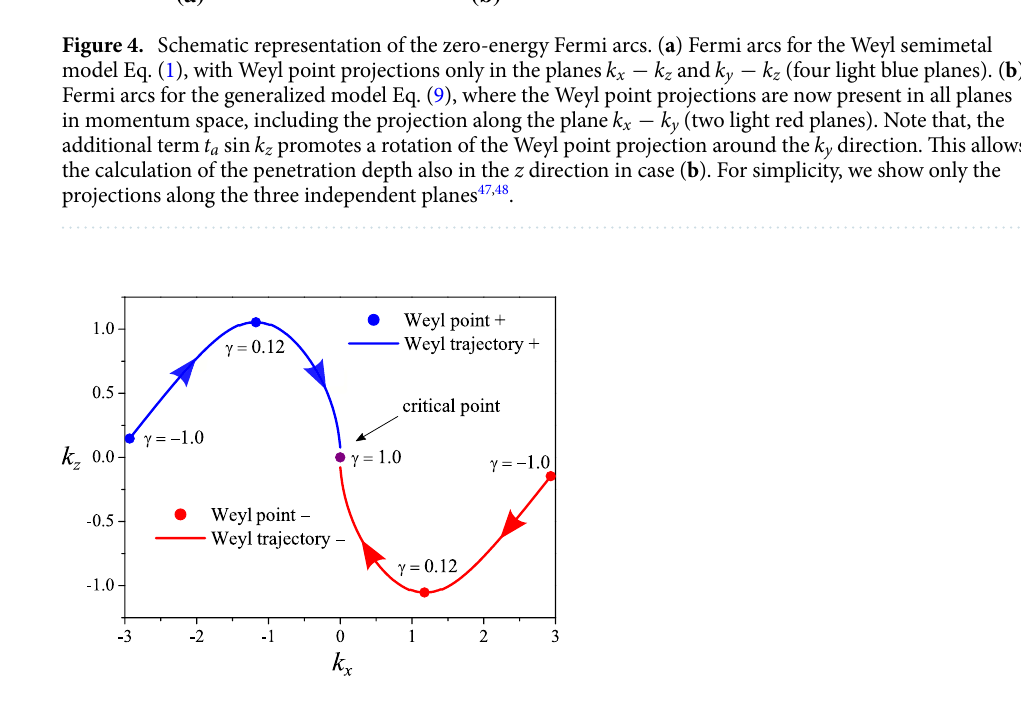
k z plane for y direction with open-boundary conditions. Figure 5. Trajectory of the Weyl points along the k x − The blue and red circles denote the Weyl points with positive and negative topological charges, respectively, and the solid lines indicate the corresponding Weyl trajectories. The arrows indicate the paths of the Weyl 1.0 , going through γ 0.12 , until the critical point at γ 1.0 where the Weyl points collide points from γ = − = = (purple circle) 47,48